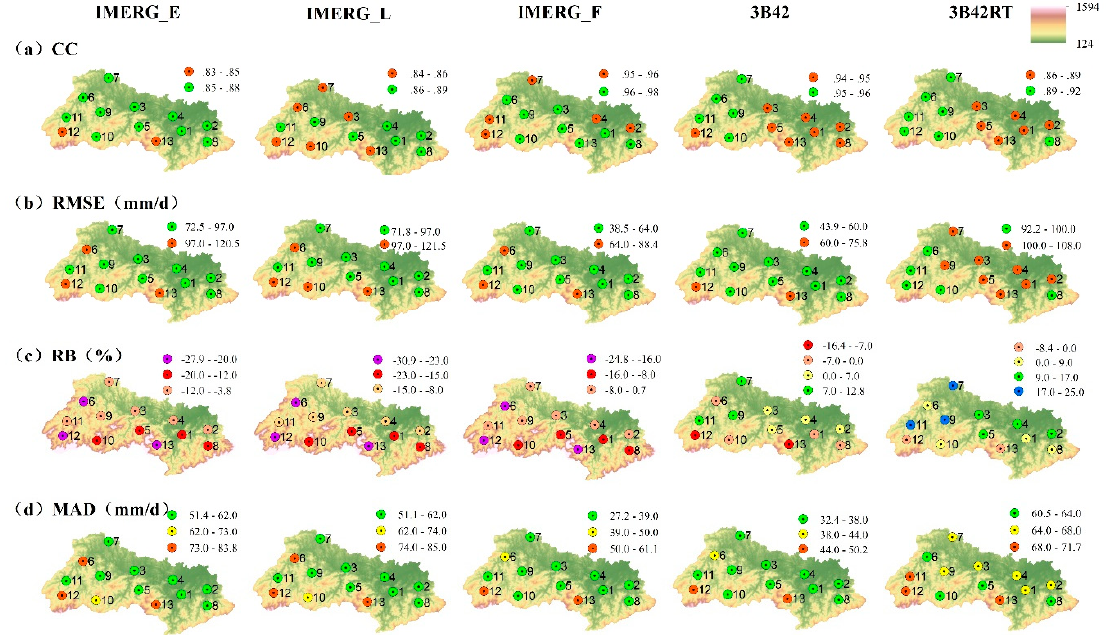
Figure 3. Spatial distribution of the annual continuous evaluation metrics at monthly scale: ( a ) CC ; ( b ) RMSE ; ( c ) RB ; and ( d ) MAD .